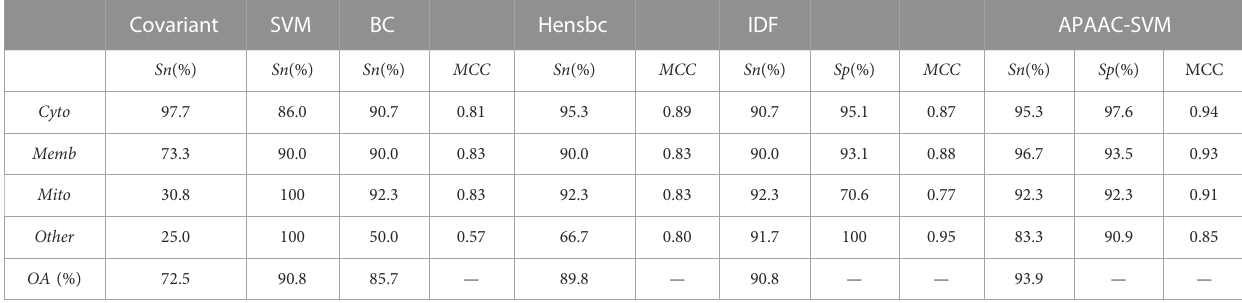
TABLE 4 Comparison of prediction performance for different methods on the ZD98 dataset.